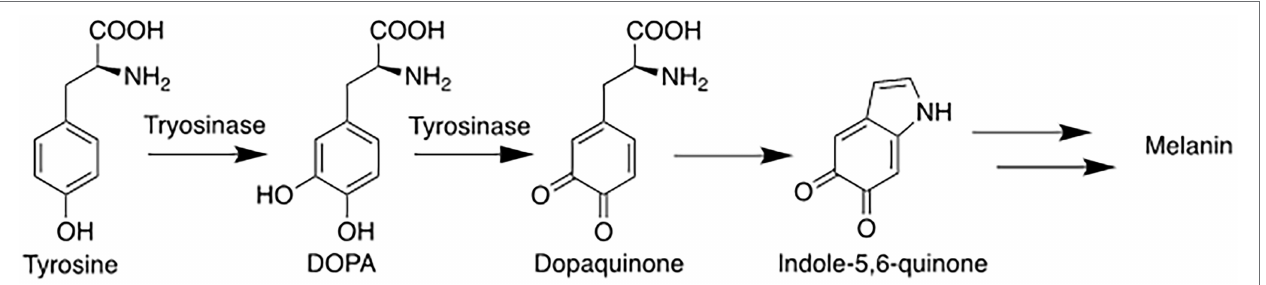
FIGURE 1 | Simplified melanin biosynthesis pathway with tyrosinase catalyzing two of the early steps from the amino acid